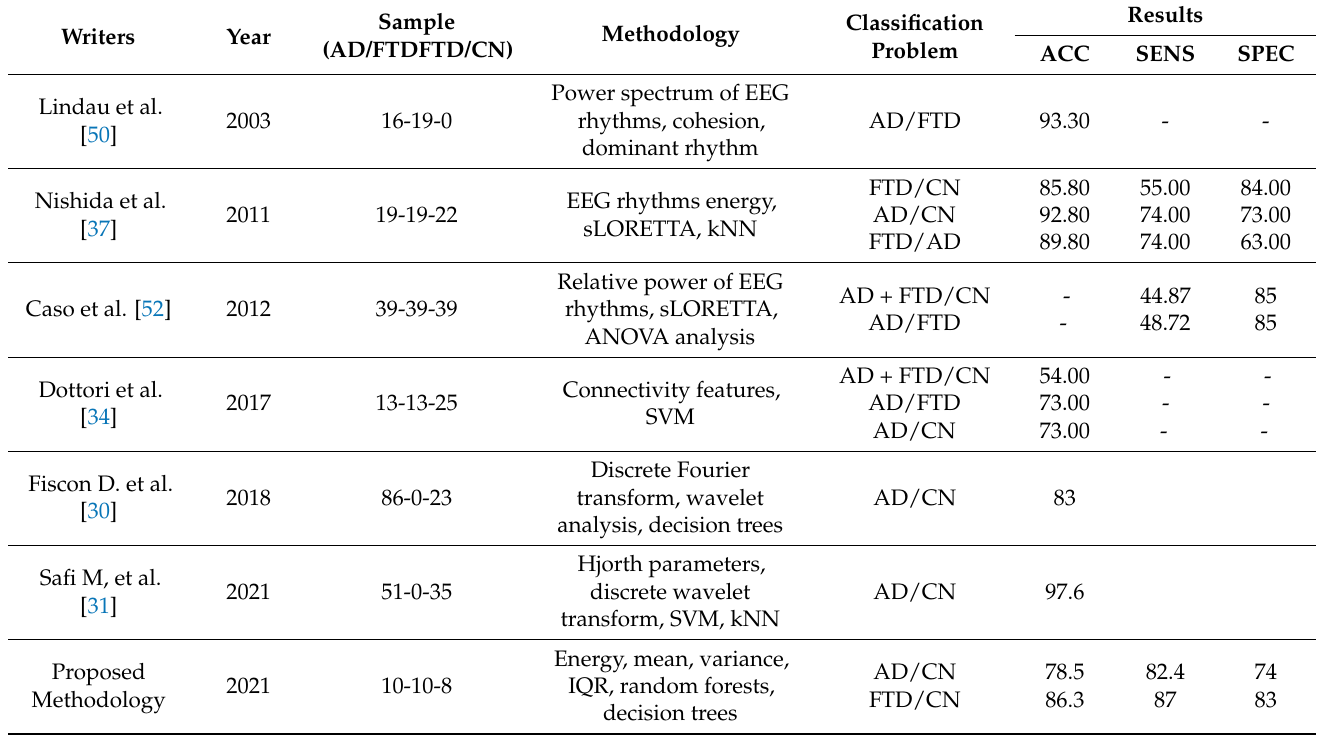
Table 5. Previous work